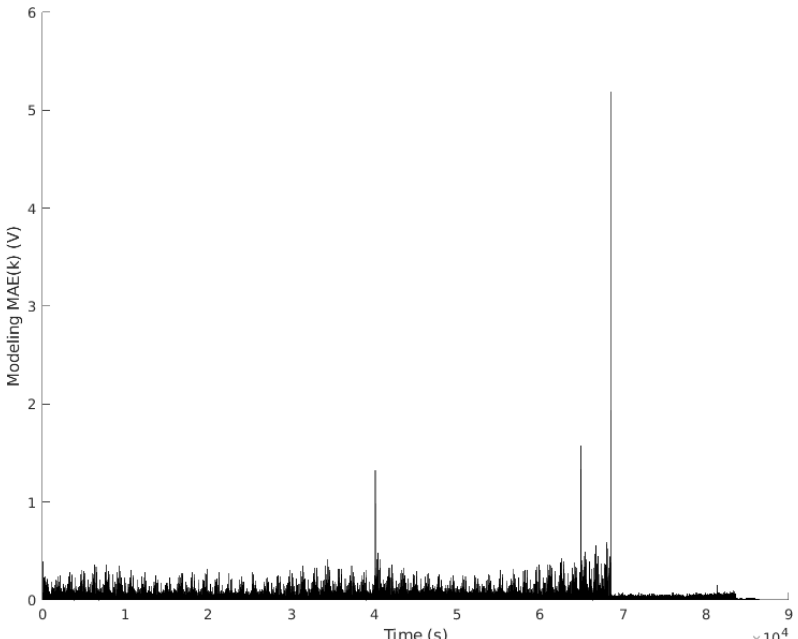
Figure 8. Modeling